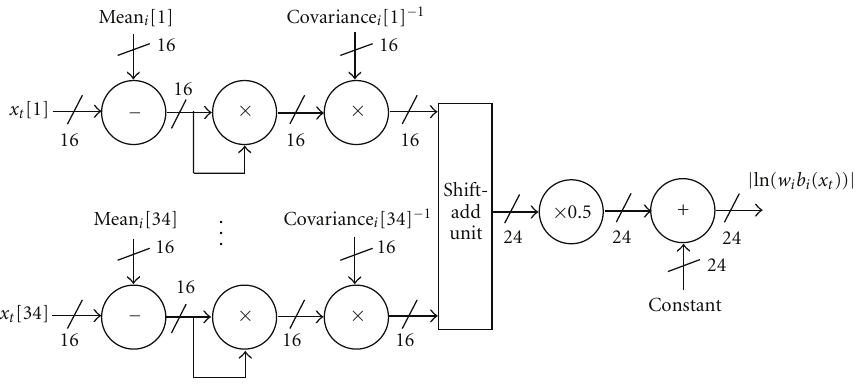
Figure 8: Dataflow diagram showing the calculation of (17).